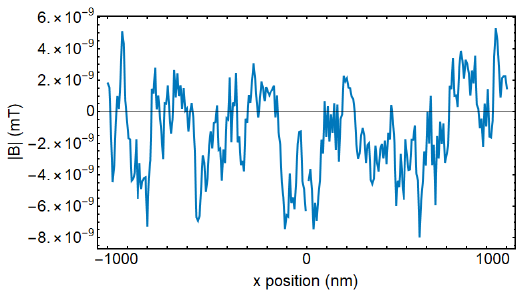
Figure 13: B field component along the wire for the double Dragonfly with the z middle ninth magnet. The B data for other set-ups available on Zenodo [ 33 ] . z